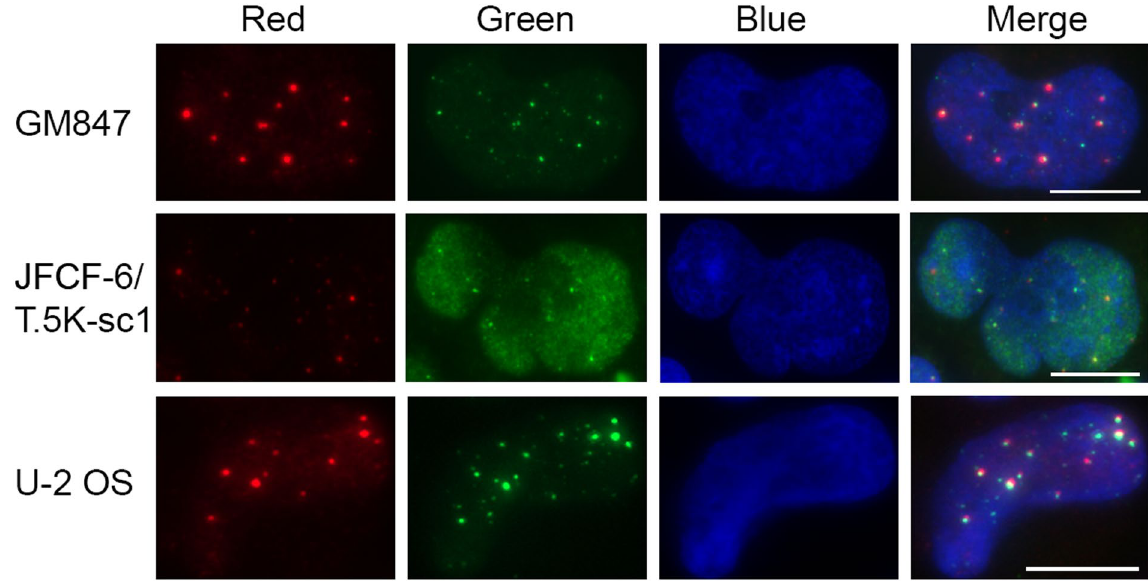
Figure 2. Background varies among cell lines and channels. Examples of three nuclei with varying degrees of background in the red and green channels. Cell line names are indicated to the left of each row. GM847 and JFCF-6/T.5K-sc1 cells were stained with antibodies recognising PML protein (red) and TRF2 protein (green), while U-2 OS cells were stained for PML protein (red) and telomeric DNA (green). 4 ′ ,6-diamidino-2- phenylindole (DAPI; blue) was used as a DNA counterstain. Scale bar indicates 10 μ